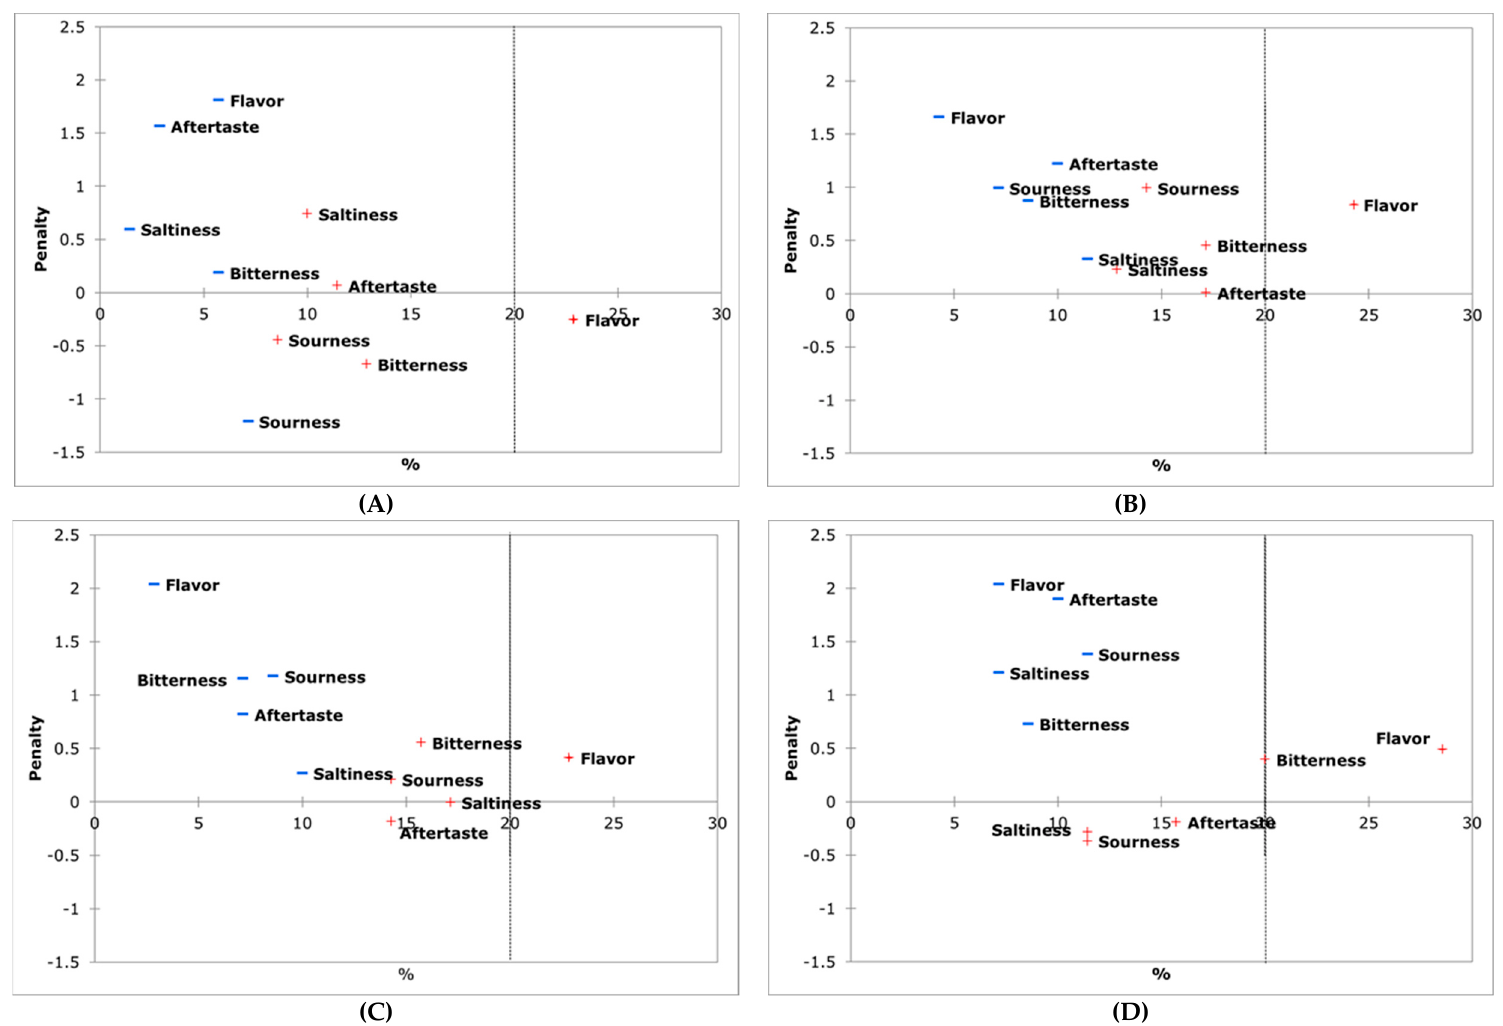
Figure 3. Penalty analysis of samples (A ) = T0; ( B) = T1; (C) = T2; (D) = T3. “Too low intensity” is indicated with “ − “ and “too high intensity” is indicated with “+”.